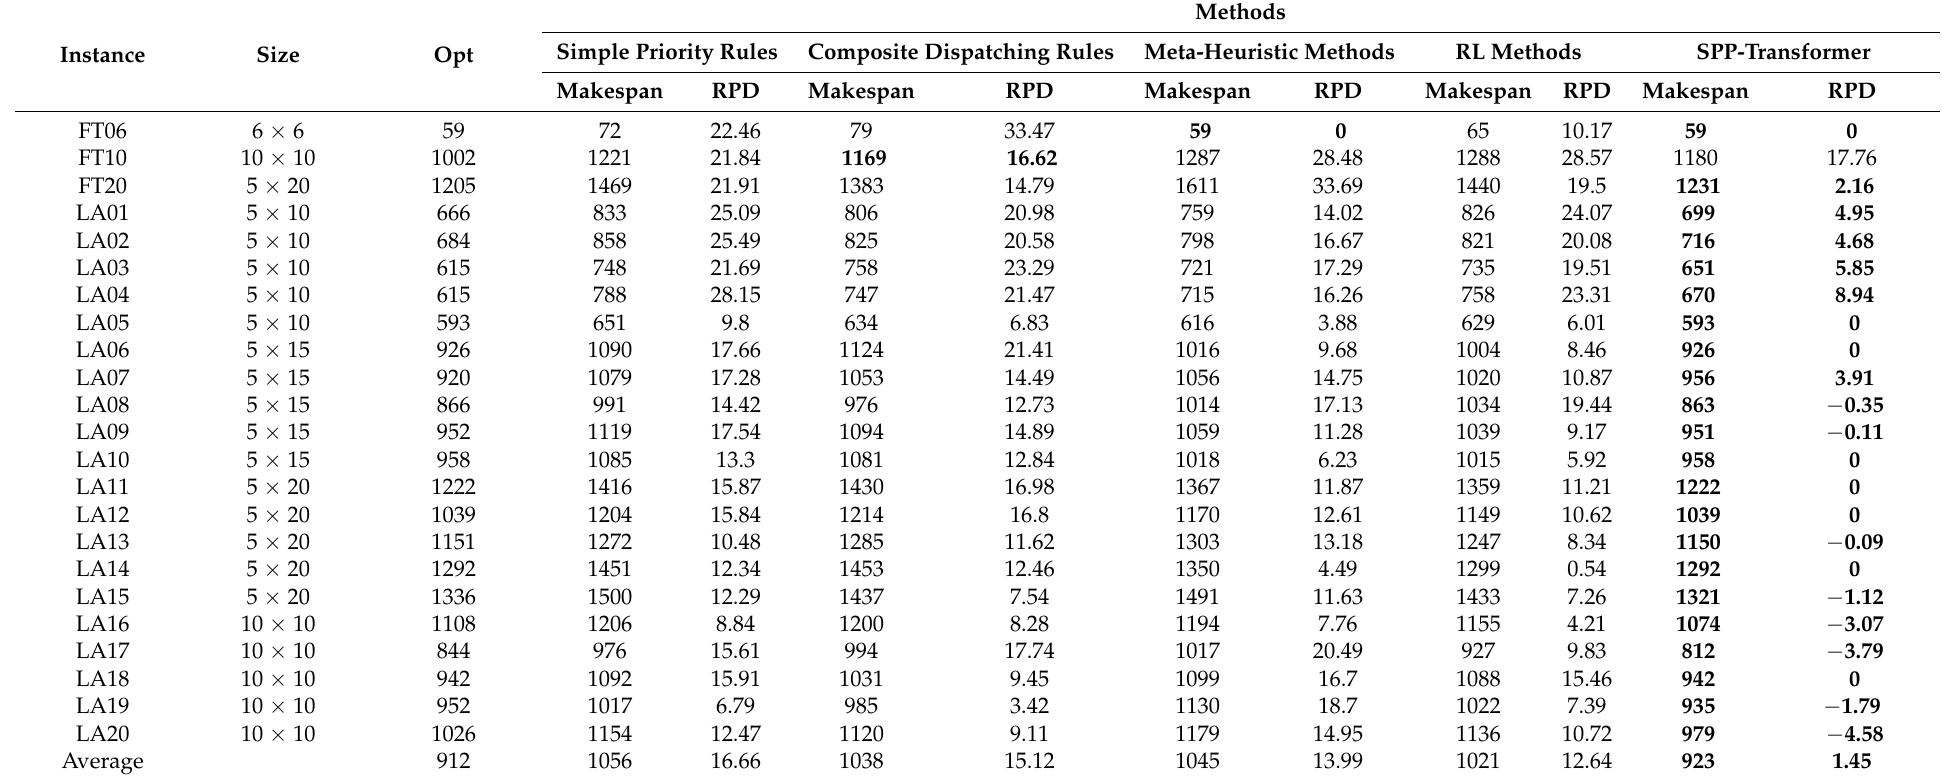
Table 3. The comparison between each method on makespan and RPD